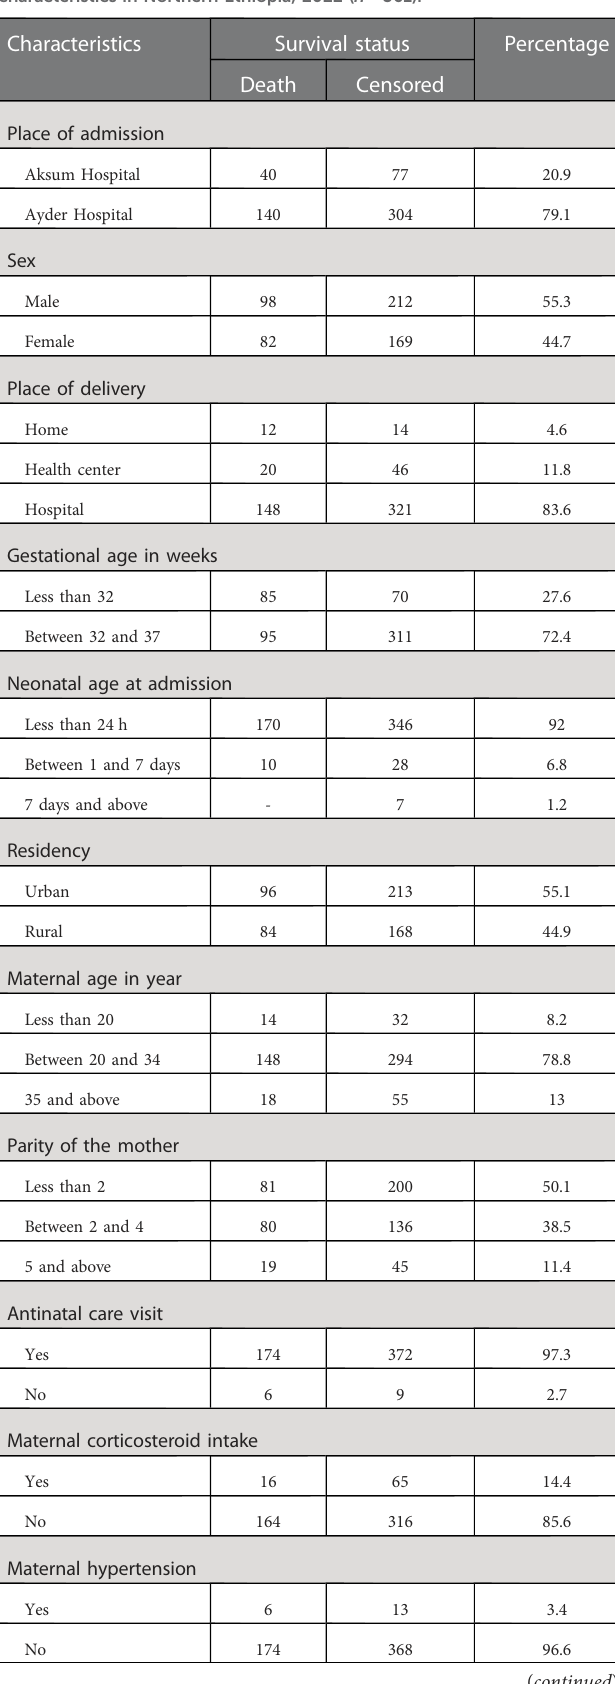
TABLE 1 Distribution of sociodemographic and obstetric-related characteristics in Northern Ethiopia, 2022 ( n =561). Characteristics